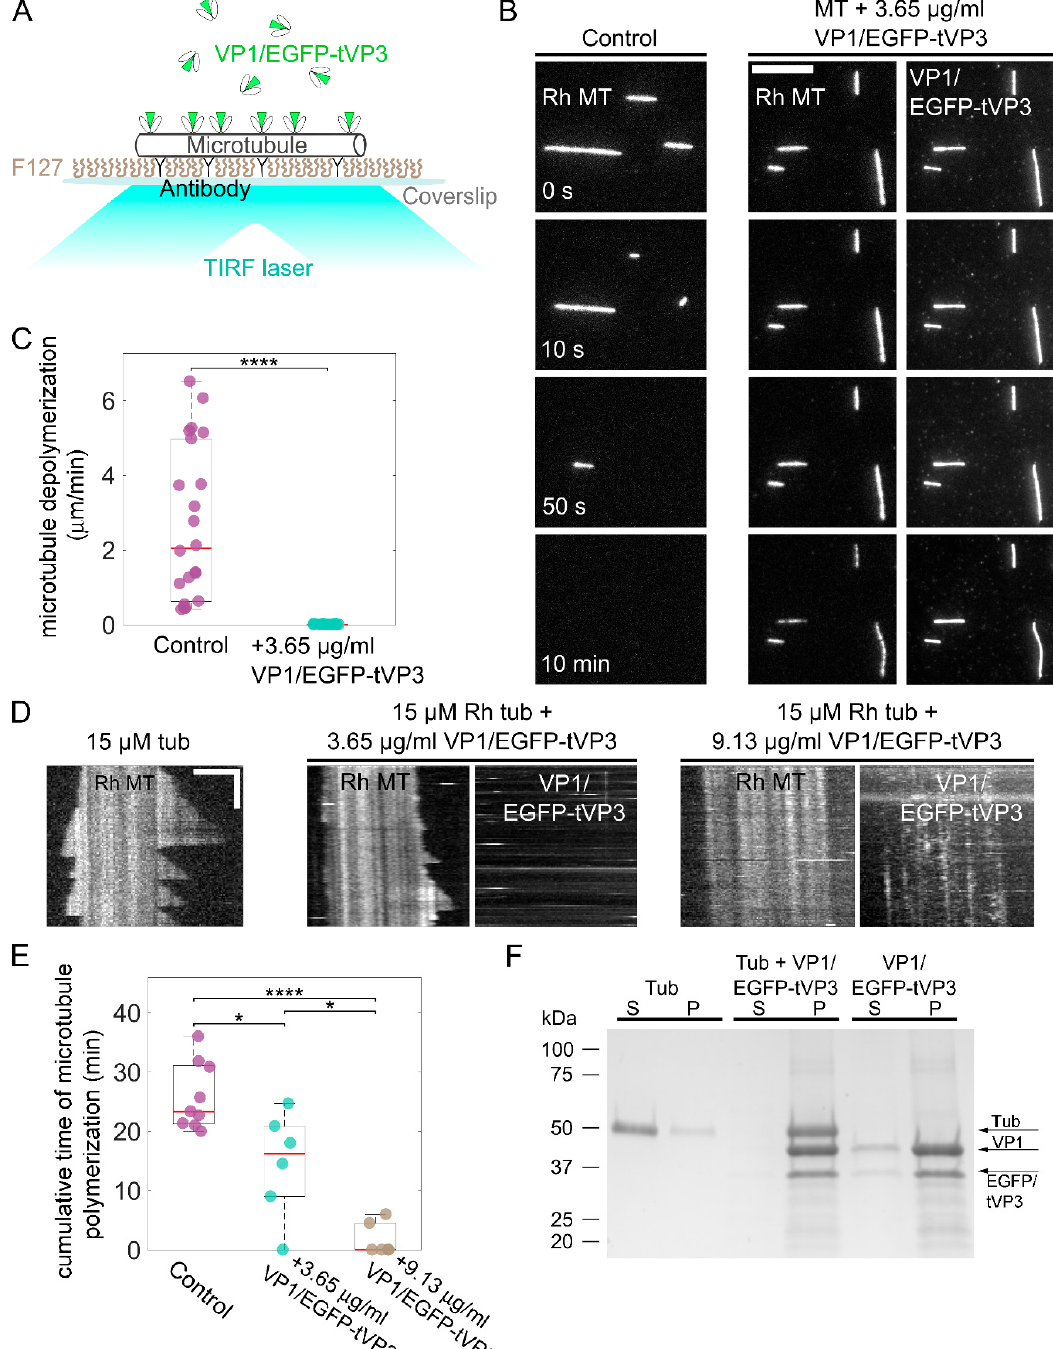
Figure 4. VP1 directly binds microtubules and stabilizes them. ( A ) A schematic diagram of a microtubule binding assay with VP1/EGFP-tVP3. ( B ) Time-lapse fluorescence micrographs of rhodamine-labeled microtubules (Rh MT) depolymerizing in the absence or presence of 3.65 µg/mL VP1/EGFP-tVP3. Scale bar, 10 µm. ( C ) Depolymerization rates of taxol-stabilized rhodamine-labeled microtubules in the absence (control) or presence of 3.65 µg/mL VP1/EGFP-tVP3. Control: 2.67 ± 2.07 µm/min ( N = 22). Microtubules + 3.65 µg/mL VP1/EGFP-tVP3: 0.01 ± 0.01 µm/min ( N = 16); values are the mean ± SD. Red lines represent the median values; the bottom and top edges of the box indicate the 25th and 75th percentiles, respectively. The whiskers extend to the extreme data points. ( D ) Kymographs showing dynamic microtubules polymerizing with 15 µM free rhodamine-labeled tubulin in the absence